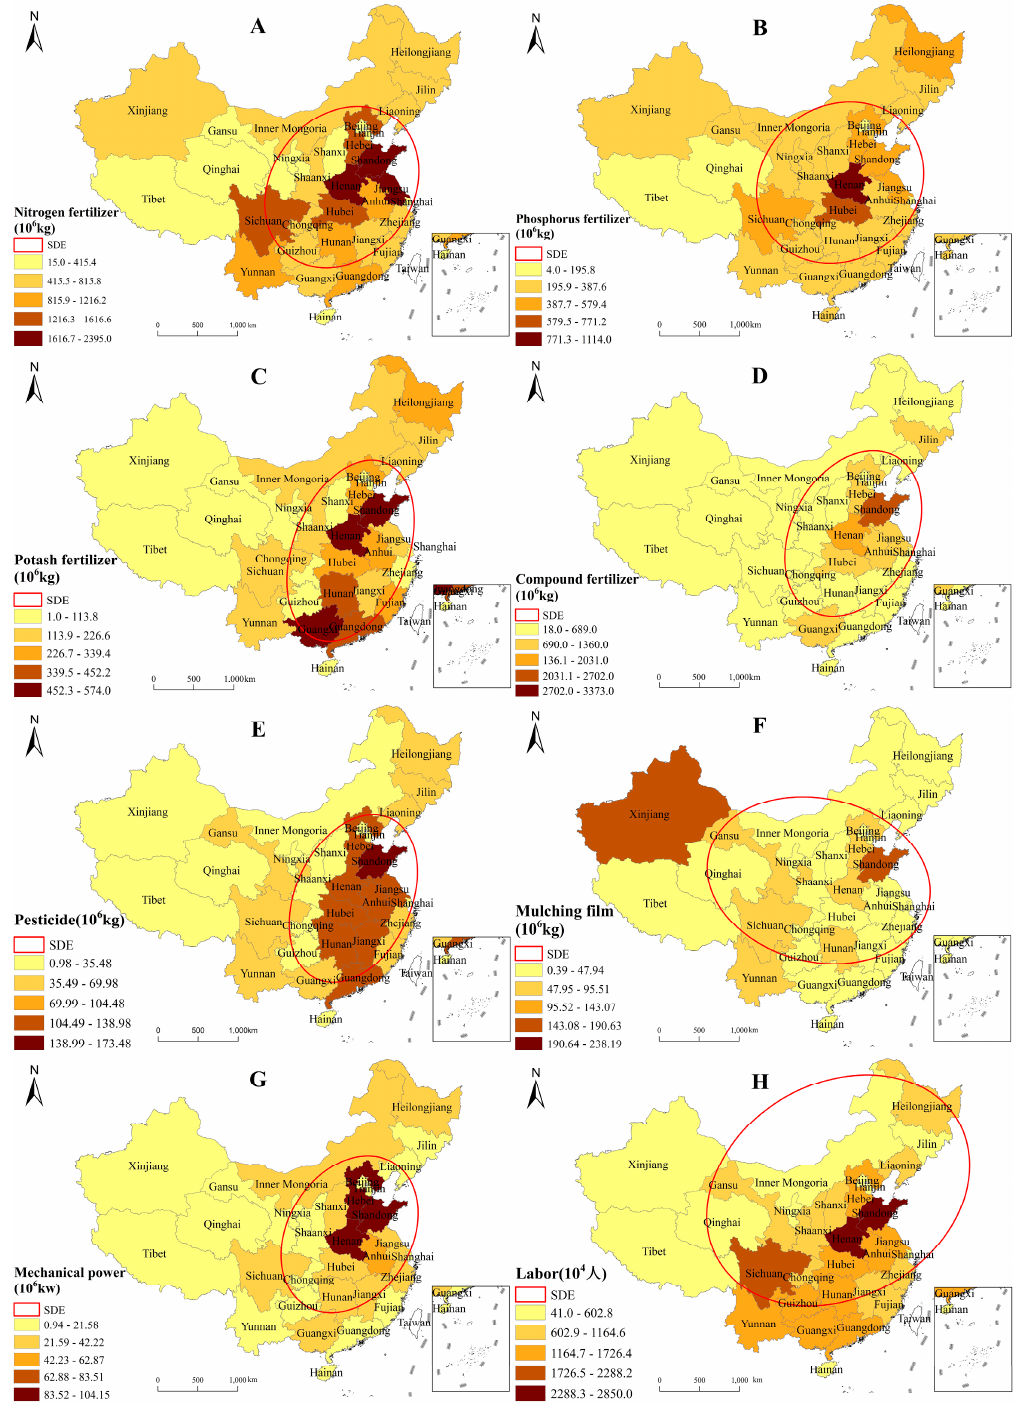
Figure 2. Input of production material on arable land in